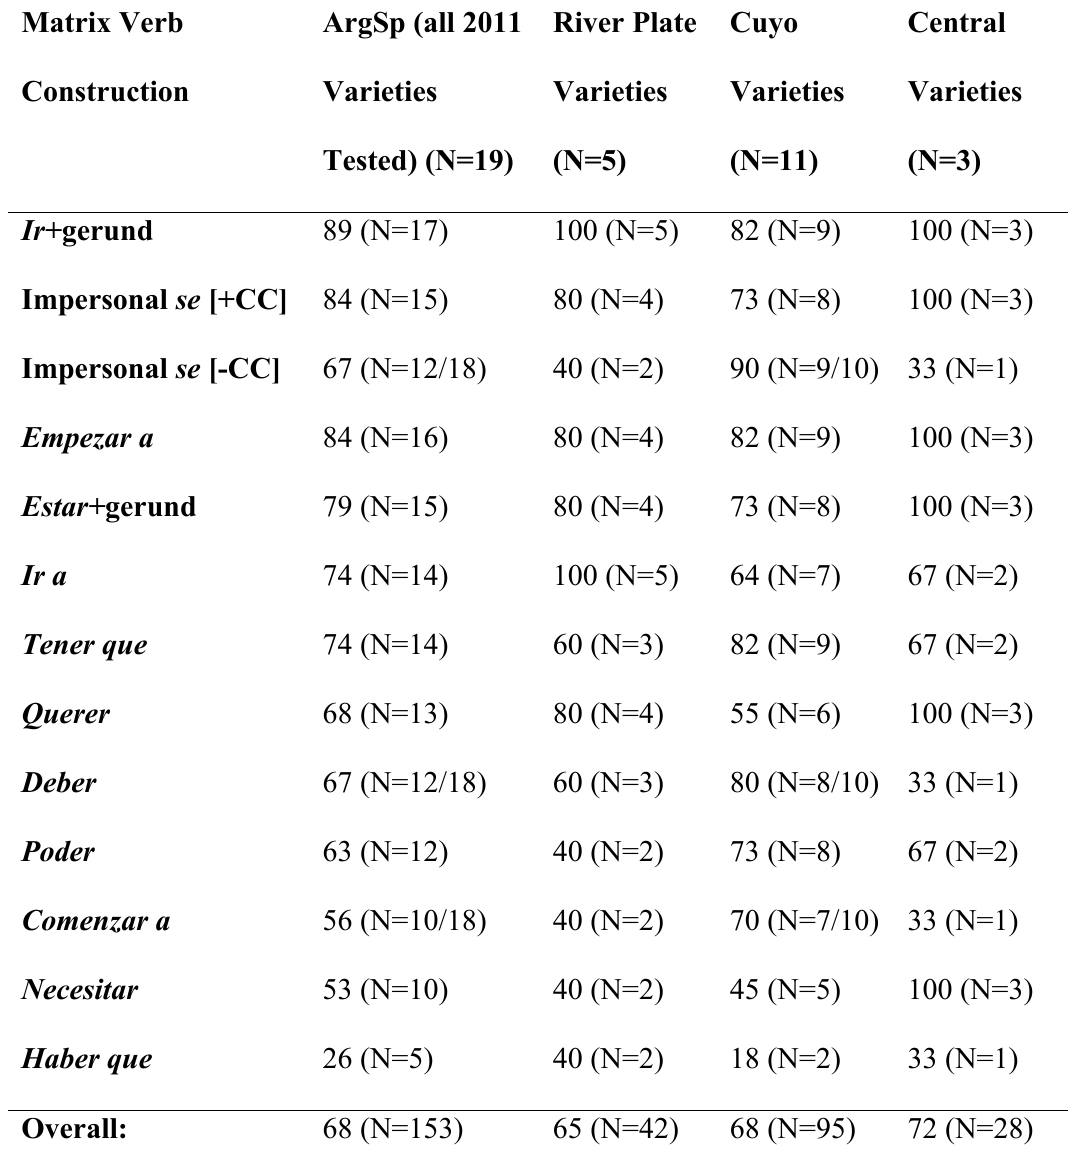
Table 6 . Percentage of [+CC] acceptability to first degree of grammaticality in 2011 data by matrix verb and ArgSP